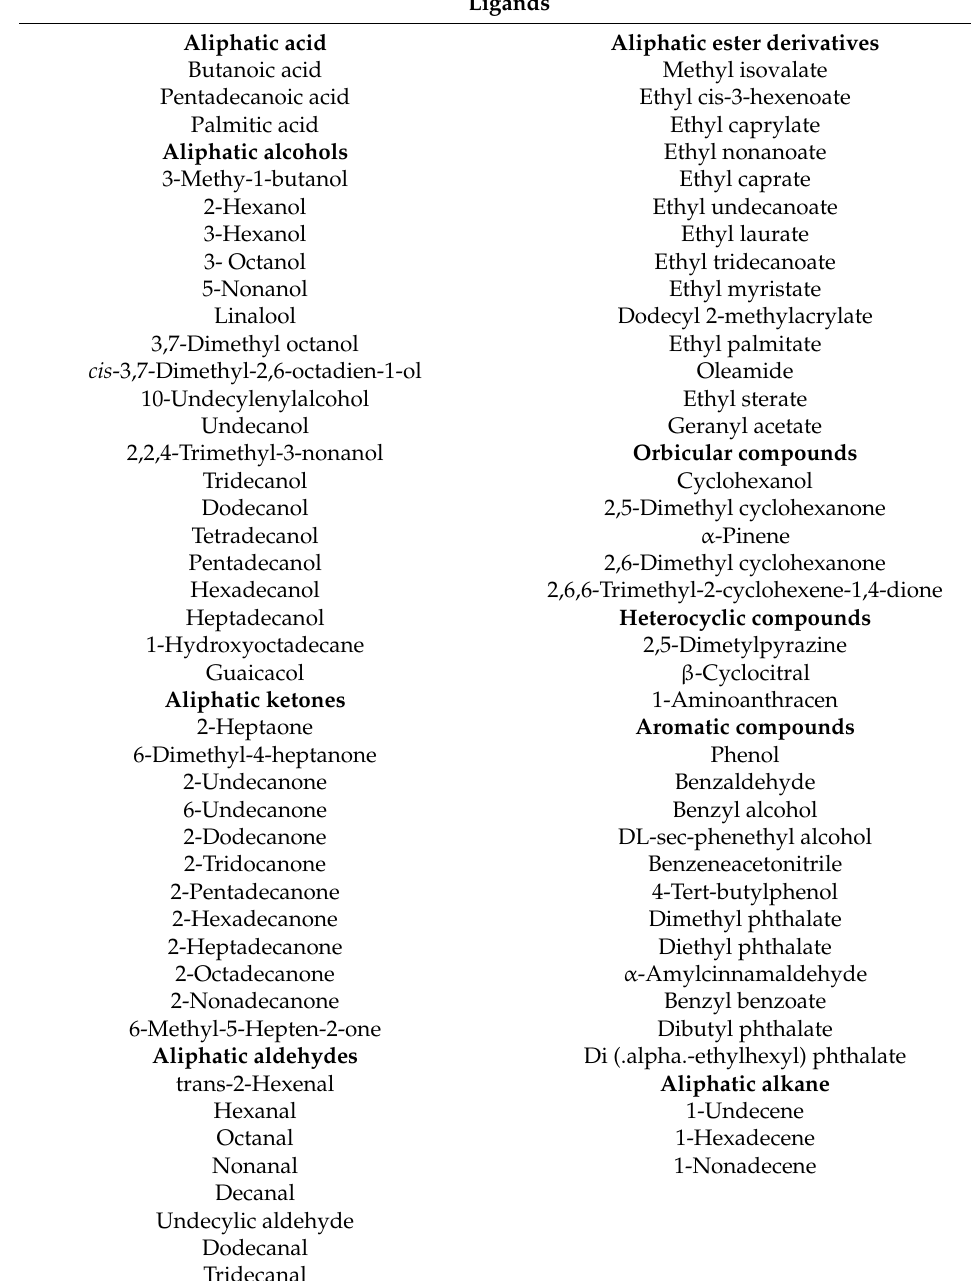
Table 2. Compounds used as